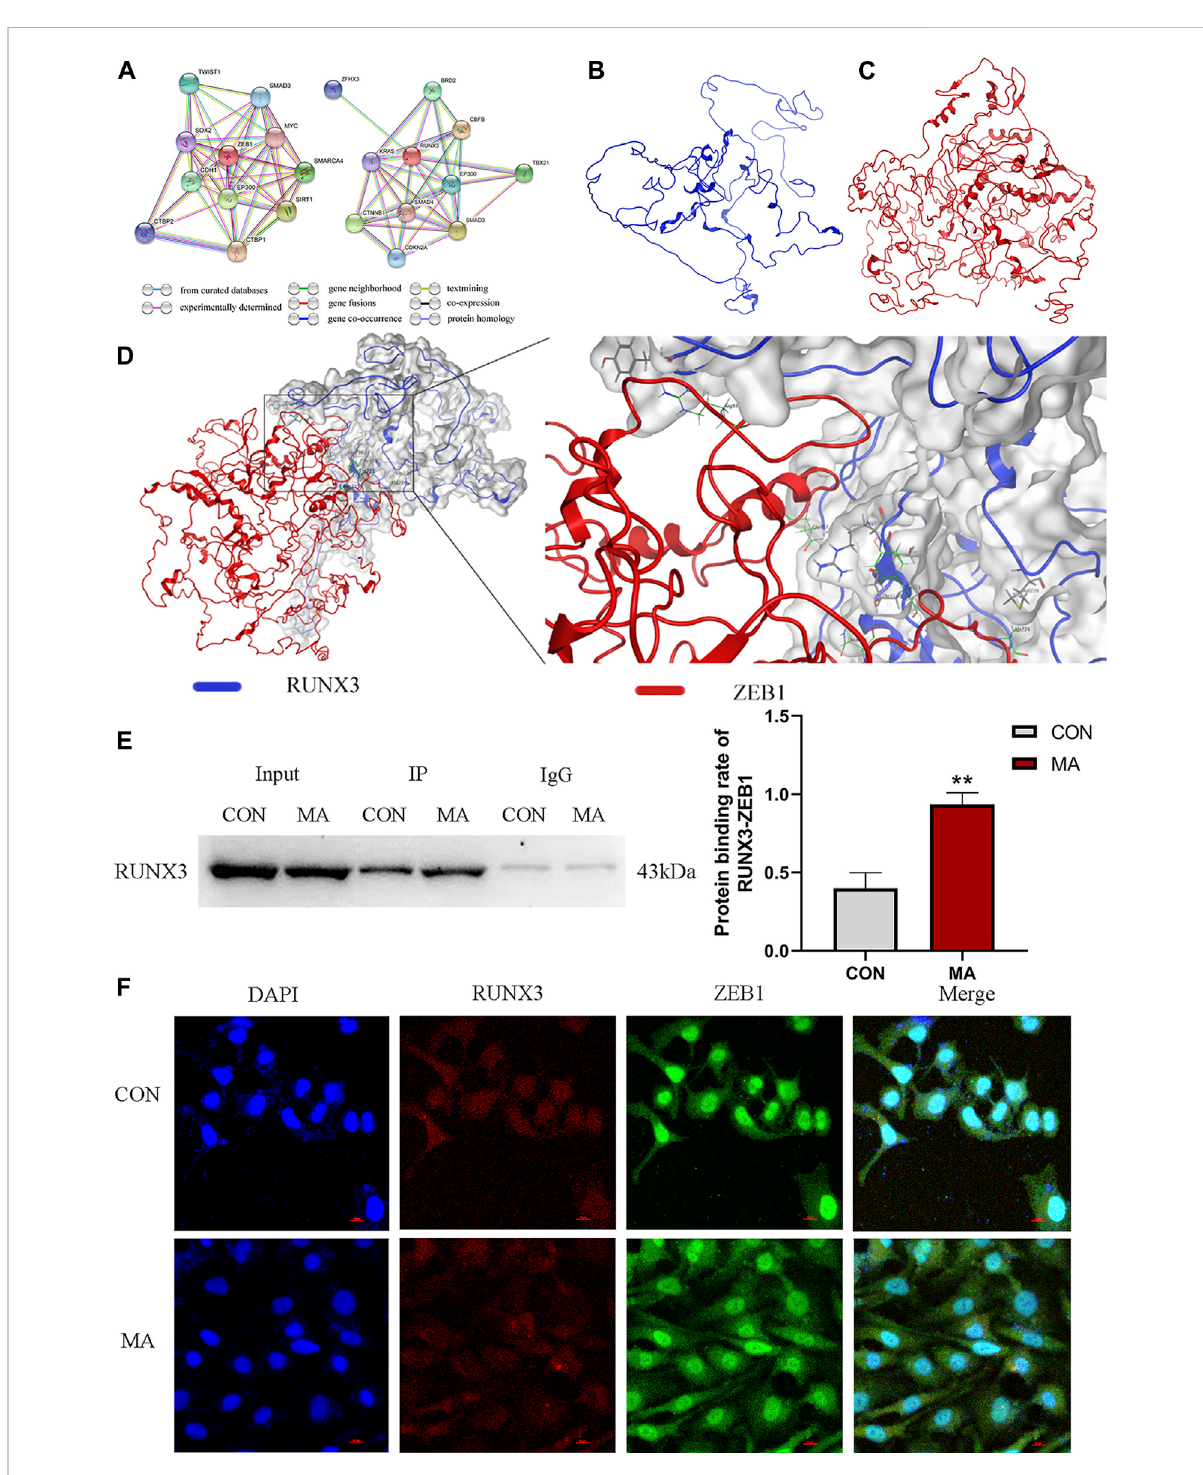
FIGURE 5 Protein-protein interactions (PPIs) betweenRUNX3 and ZEB1. (A) RUNX3-related gene network and ZEB1-related gene networks generated by STRING database. This network uses different color nodes to represent different proteins (ZFH3, BRD2, KRAS, RUNX3, CBFB, CTNNB1, SMAD4, EP300,TBX21,CDKN2A,SMAD3;TWIST1,SMAD3, SOX2,ZEB1,MYC,CDH1,EP300,SMARCA4,SIRT1,CTBP1,CTBP2).Differentcolorlinesrepresent different interactions at different gene levels (gene neighborhood, gene fusions, gene co-occurrence) or the protein levels (co-expression, protein homology). (B) The protein structure of RUNX3 predicted by the Robetta data bank. (C) The protein structure of ZEB1 predicted by the I-TASSER server. (D) Molecular docking of RUNX3 with ZEB1 using MOE software. MOE analysisshowed the binding sites of thedocking structure of